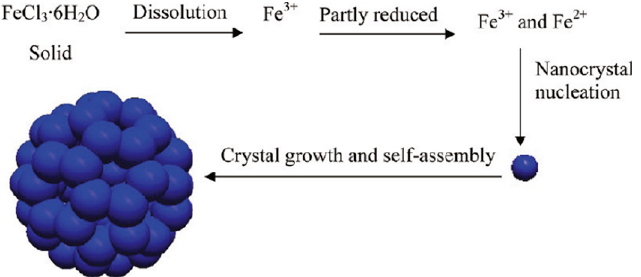
Figure 28. Preparation of porous Fe 3 O 4 nanospheres. (Reprinted with permission from [204]. Copyright © 2011, American Chemical Society).